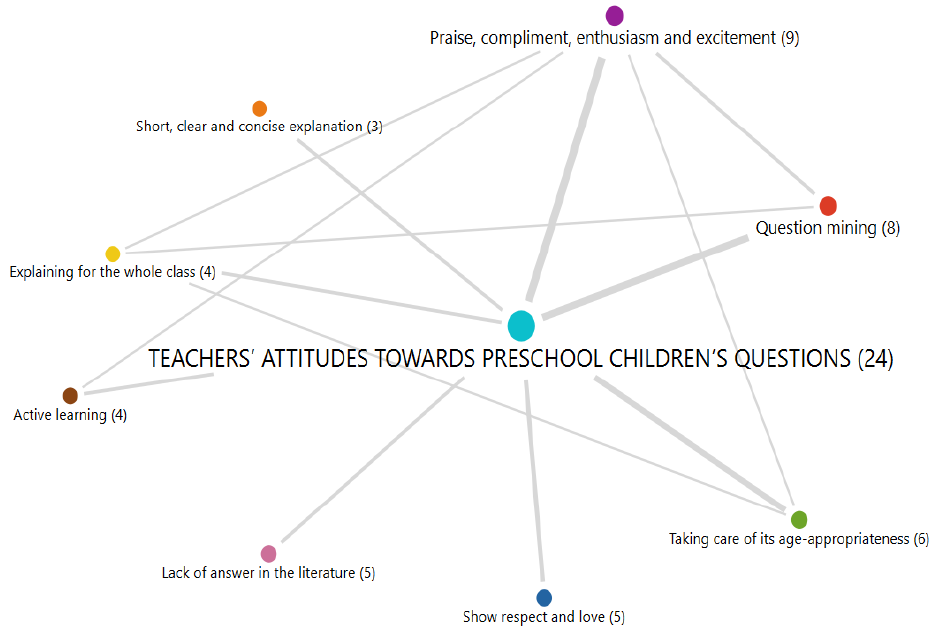
Figure 5. Attitudes of teachers to preschool children ’ s questions.